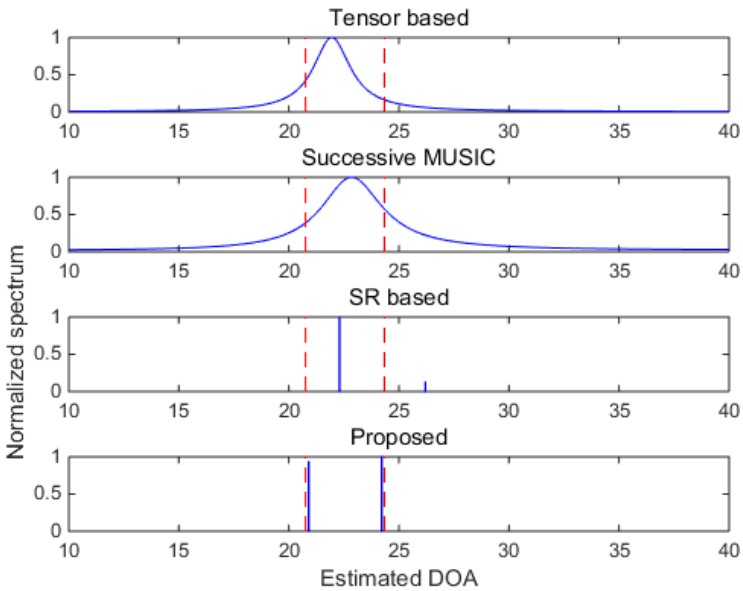
Figure 8. DOA estimation results with closely spaced sources (SNR = − 5 dB).